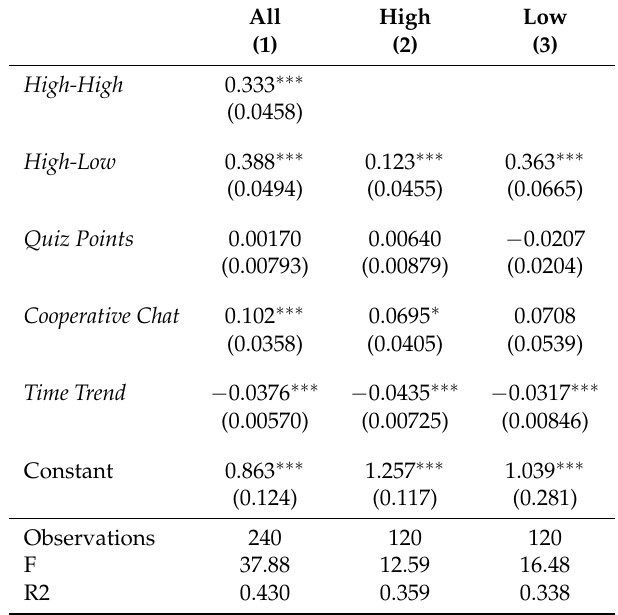
Table A19. Linear regressions: helping rates in Part B—merged group treatment—with controls. All